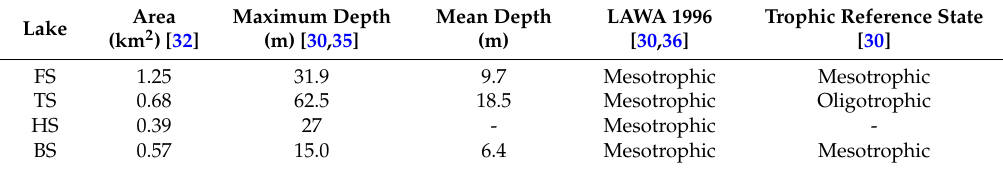
Table 2. Overview of morphology and limnological characteristics of the lakes in the Klocksin Lake Chain. Area Maximum Depth Mean Depth LAWA 1996 Trophic Reference State Lake (km 2 ) [32] (m) [30,35] (m) [30,36] [30]